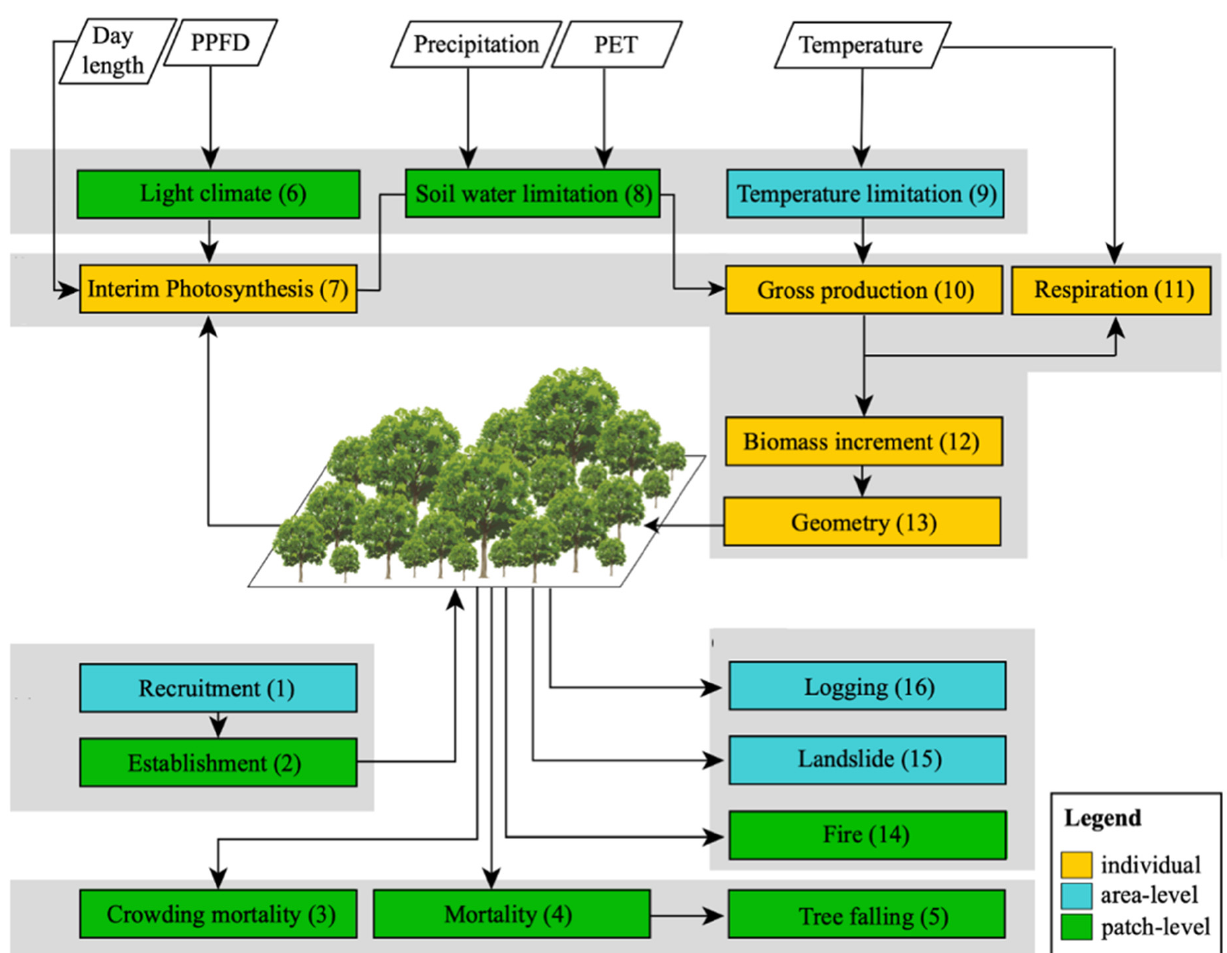
Figure 5. Schematic of the FORMIND model. Main processes are in white, and parallelograms indicate climatic parameters, some of which are required to run the model (abbreviations: PET—potential evapotranspiration; PPFD—photoactive photon flux density). Yellow, blue, and green boxes show physiological, demographic, and optional extensions including logging, harvesting, and fire at different spatial scales. Numbers in parentheses indicate scheduled flow of individual processes within the model, and grey frames underlying boxes group them according to their processes and chapters associated with the FORMIND handbook. Reprinted from [85] with the author’s permission and under Creative Commons license.